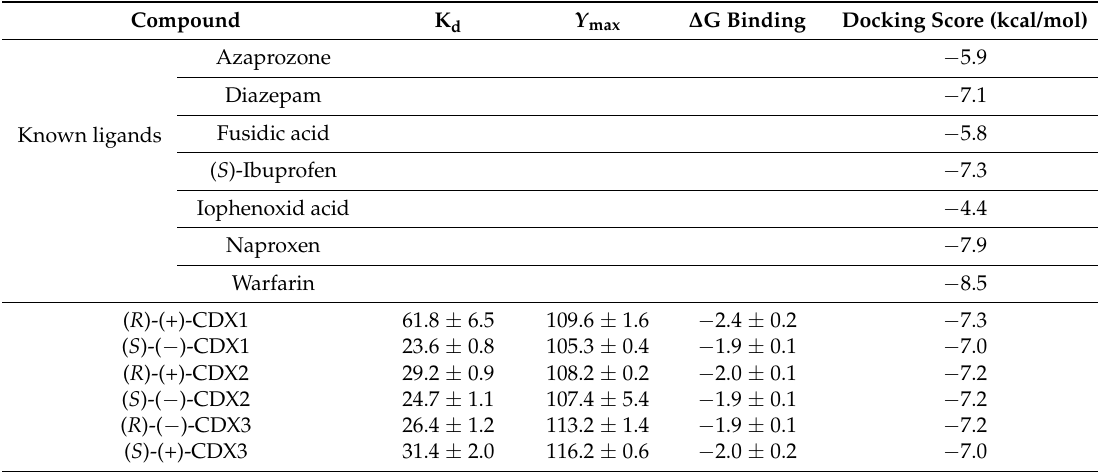
Table 3. HSA binding parameters obtained for the CDXs and predicted docking scores between HSA and CDXs. Compound K d Y max ∆ G Binding Docking Score